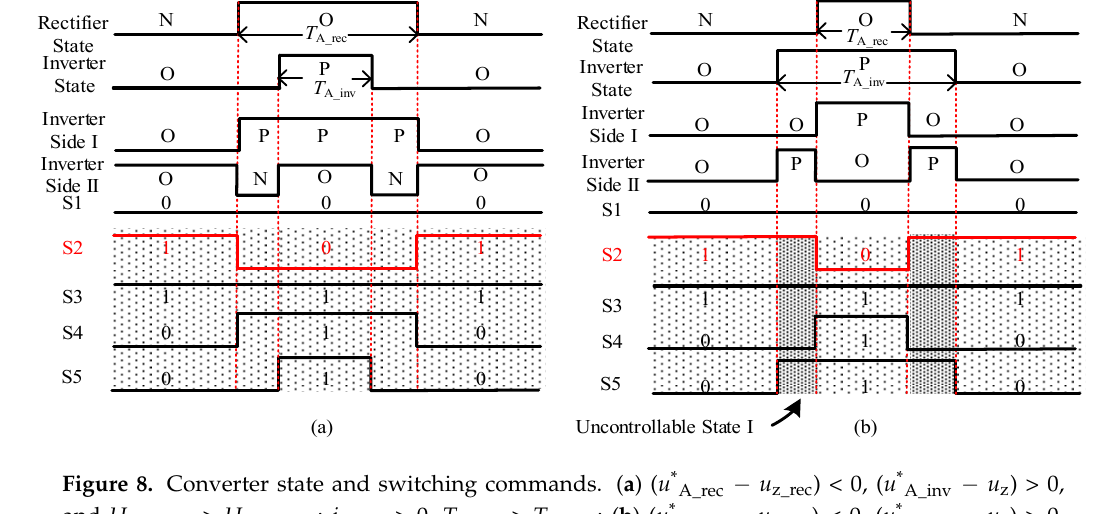
Table 5. Switching states of rectifier side and inverter side.